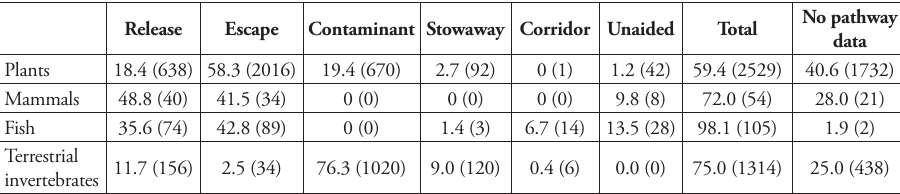
Table 1. Percentages and observed counts (in brackets) of pathways identified for individual taxonomic groups. Totals show the percentage and number of alien species for which a pathway is known. Note that species can be associated with more than one pathway, so the counts do not add up to total. ‘No pathway data’ shows the percentage from all assessed taxa (total + no data) and the number of species that meet the criteria of establishment or widespread distribution in Europe, but for which there is no precise enough information on